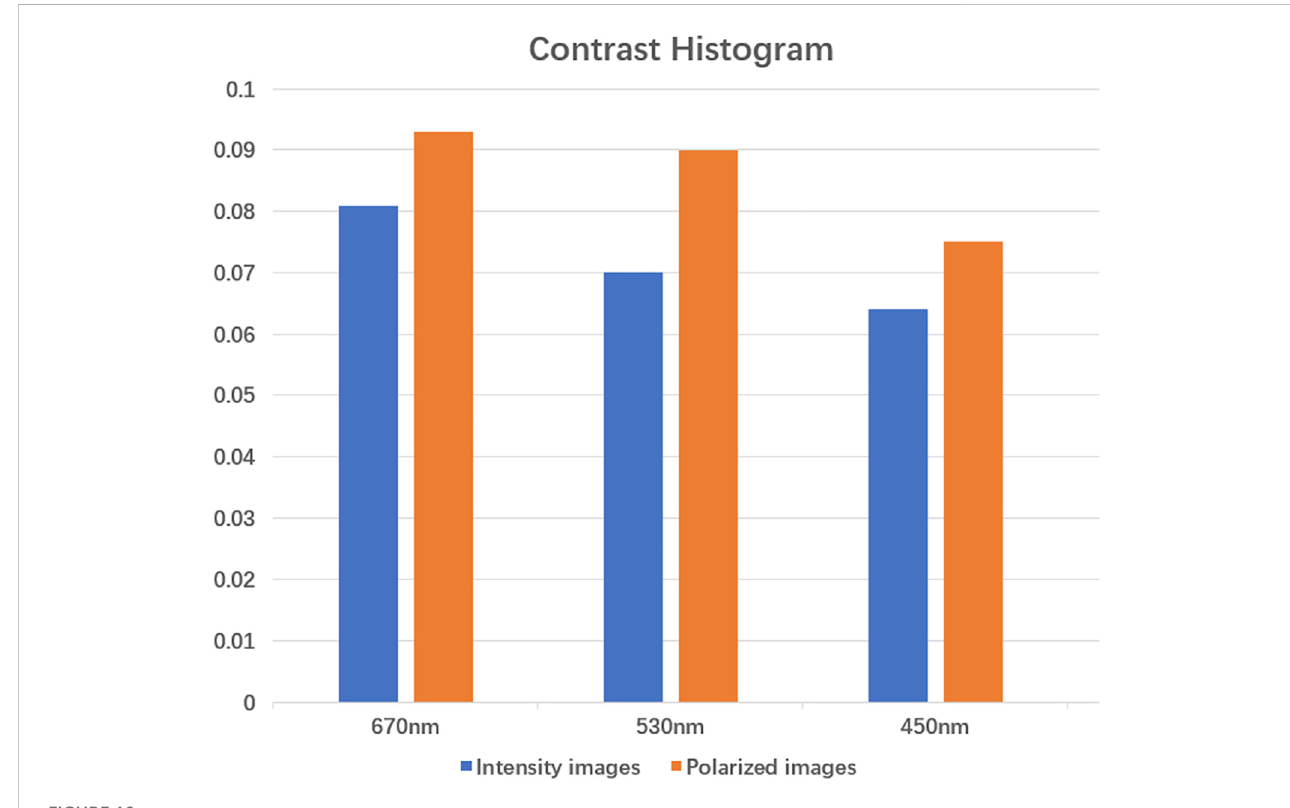
FIGURE 10 Intensity image and polarization image contrast histogram.